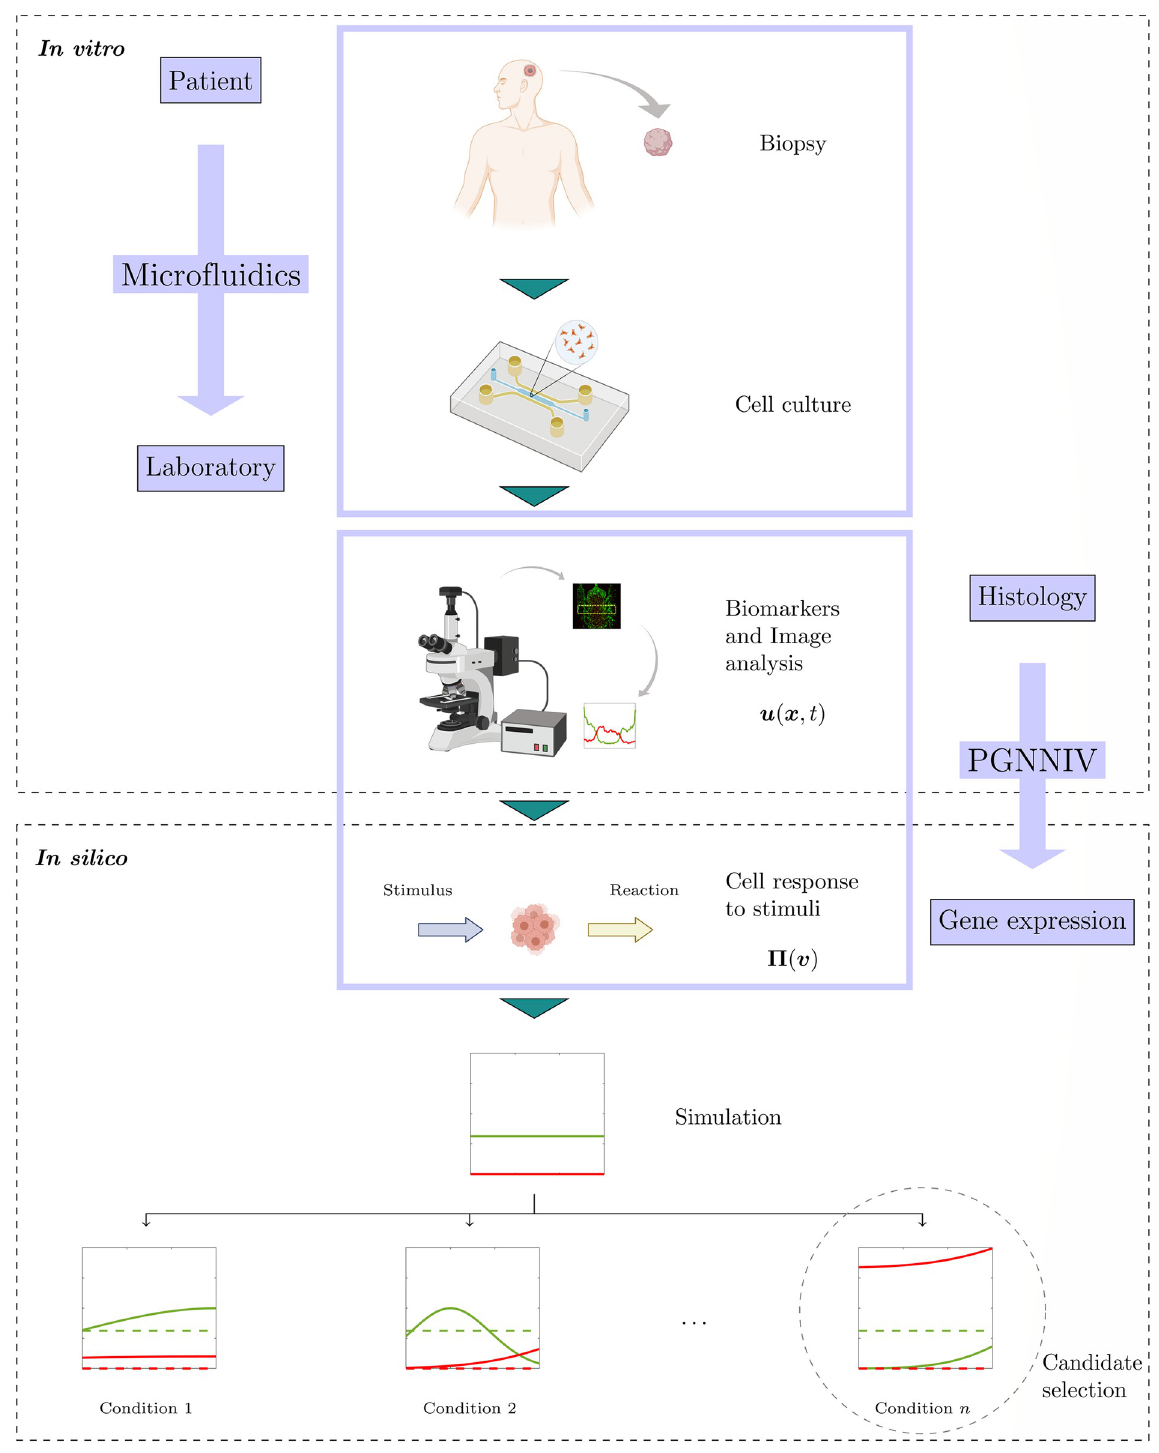
Fig 9. Summary of the described framework. Starting from the clinical patient, we can recreate histological features associated with the tumoral tissue in the microfluidic devices, extract the cell response to stimuli using PGNNIV and use the information to evaluate different therapies and drug candidates. Created with